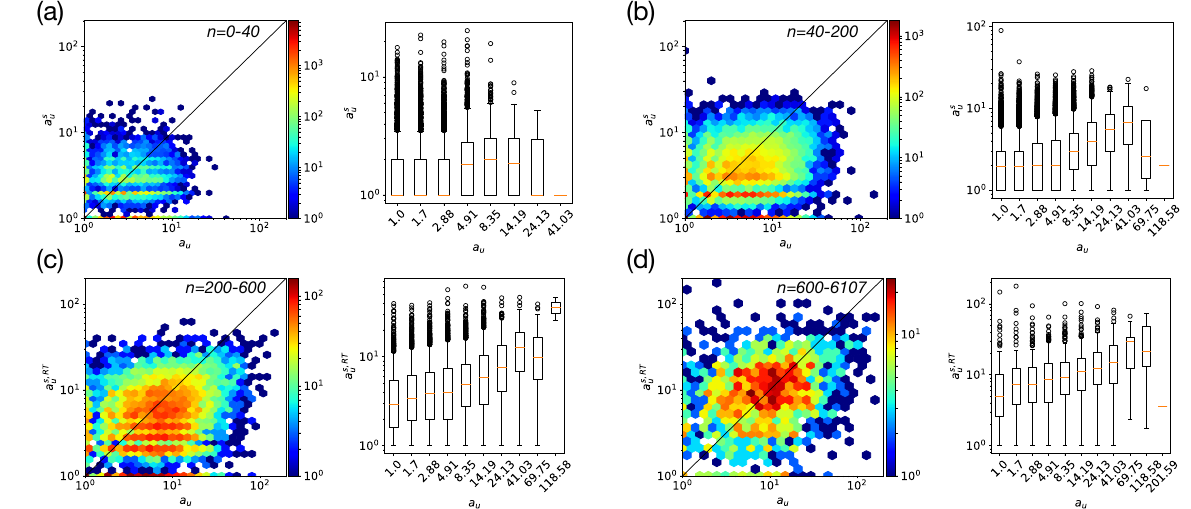
Figure 6. Panels ( a – d ): semantic attention degree vs. social attention degree, split by the number of retweets. Left panels depict correlation heatmaps between the semantic and social attention degrees of users belonging to a certain activity group. Right panels show the same information as boxplots. Activity n of users are defined as the total number of their tweets and retweets. Table 1. Pearson correlation coefficient and p-value computed between the social and semantic attentional degrees of individuals in different n retweeting activity groups. n [1, 40[ [40, 200[ [200, 600[ [600, 6107] R 0.137 0.253 0.238 <0.05